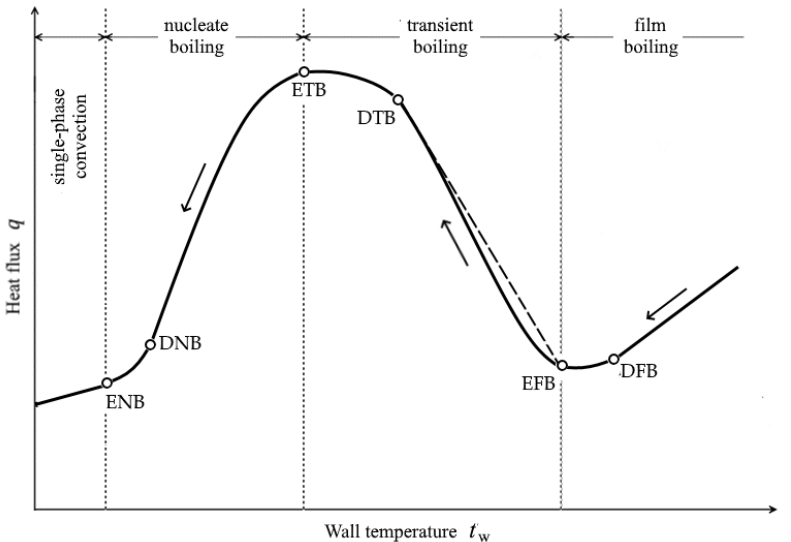
Figure 8. General view of the boiling curve. The deciphering of the reference points is given in the text. Arrows show the direction of parameter changes during cooling.